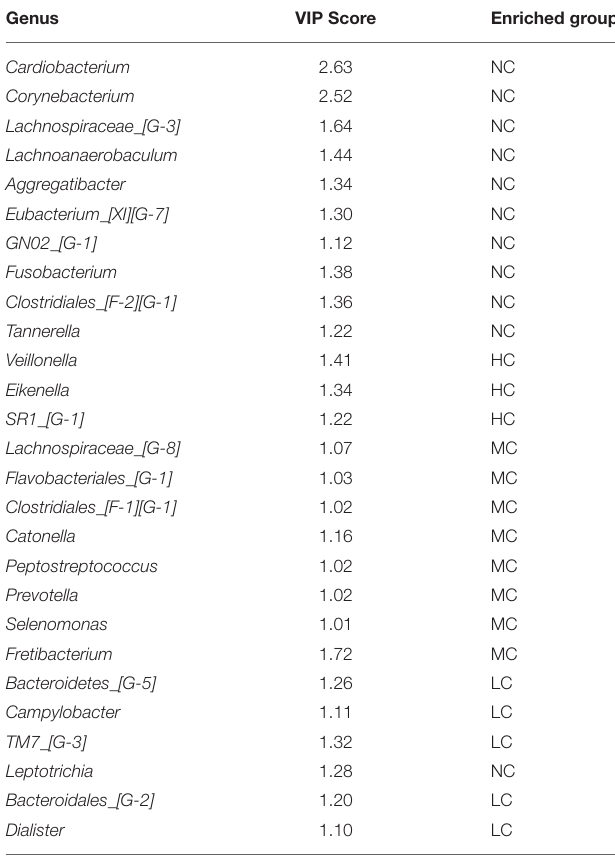
TABLE 2 | Key genera responsible for differential distributions according to the PLS-DA